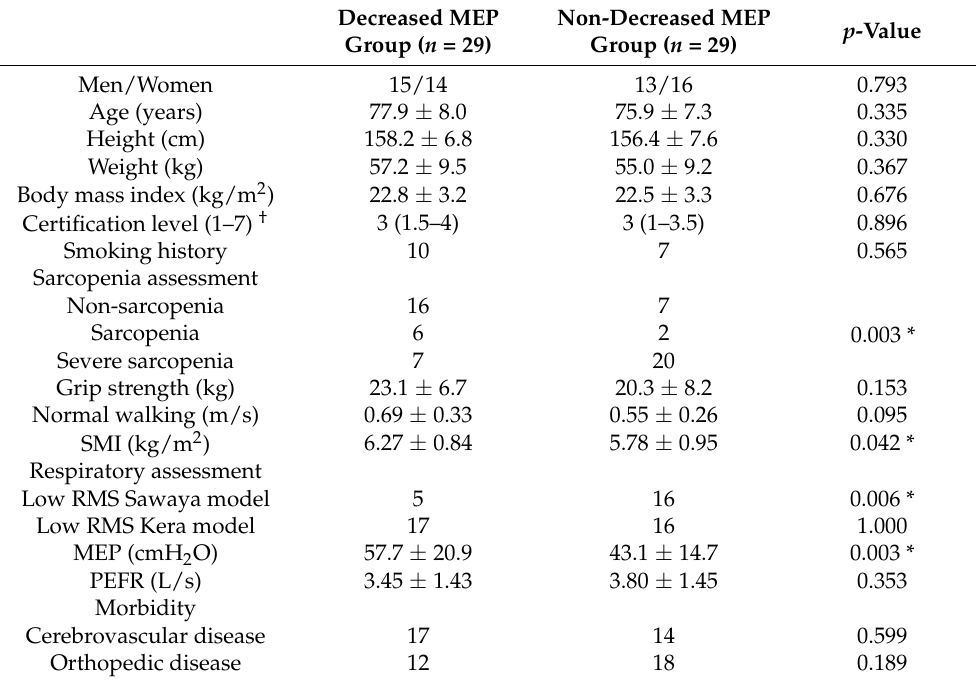
Table 1. Basic attributes and measurements at baseline.